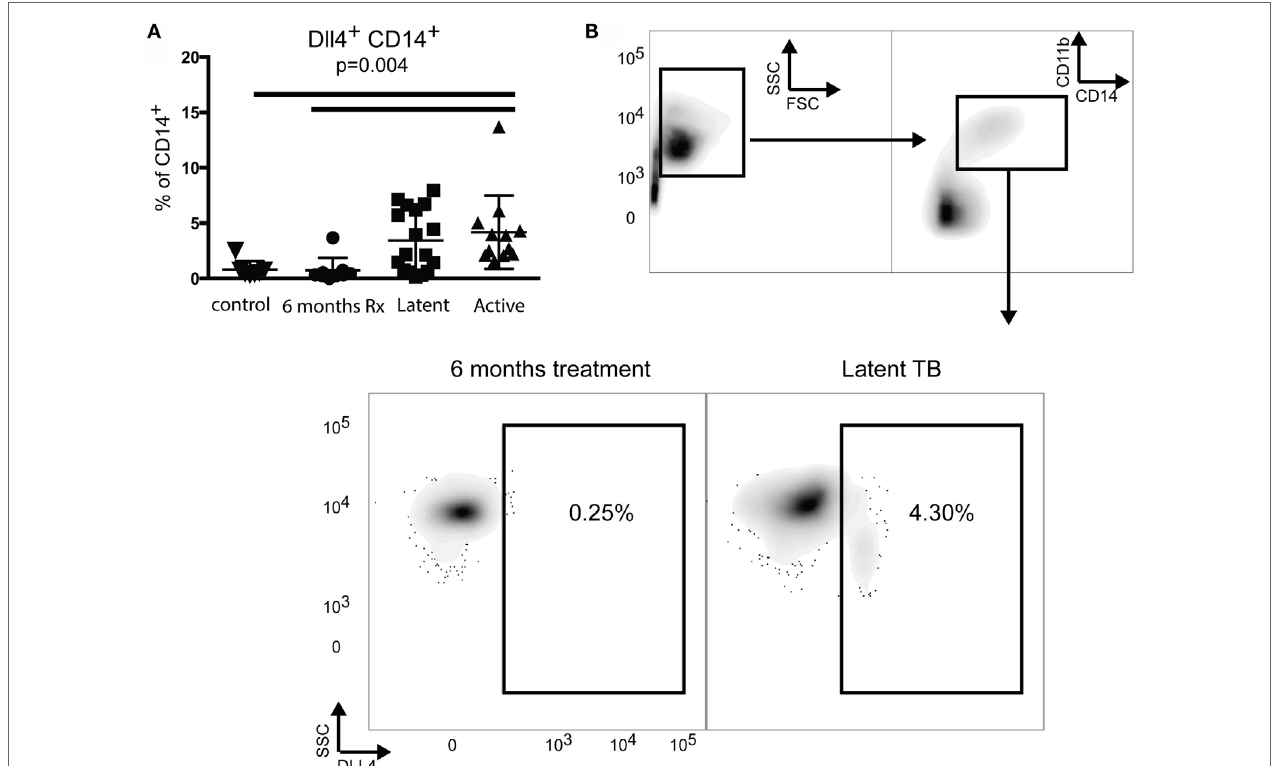
FigUre 3 | increased delta-like 4 expression in humans infected with Mtb . (a) Analysis of expression of DLL4 on CD14 + monocytes in individuals diagnosed with latent or active M. tuberculosis infection. (B) Flow cytometry plots gated on CD14 + monocytes, depicting dll4 expression of an individual treated for 6 months compared to an individual latently infected with Mtb. One-way ANOVA analysis indicated that DLL4 was expression was significantly altered during Mtb infection ( p =